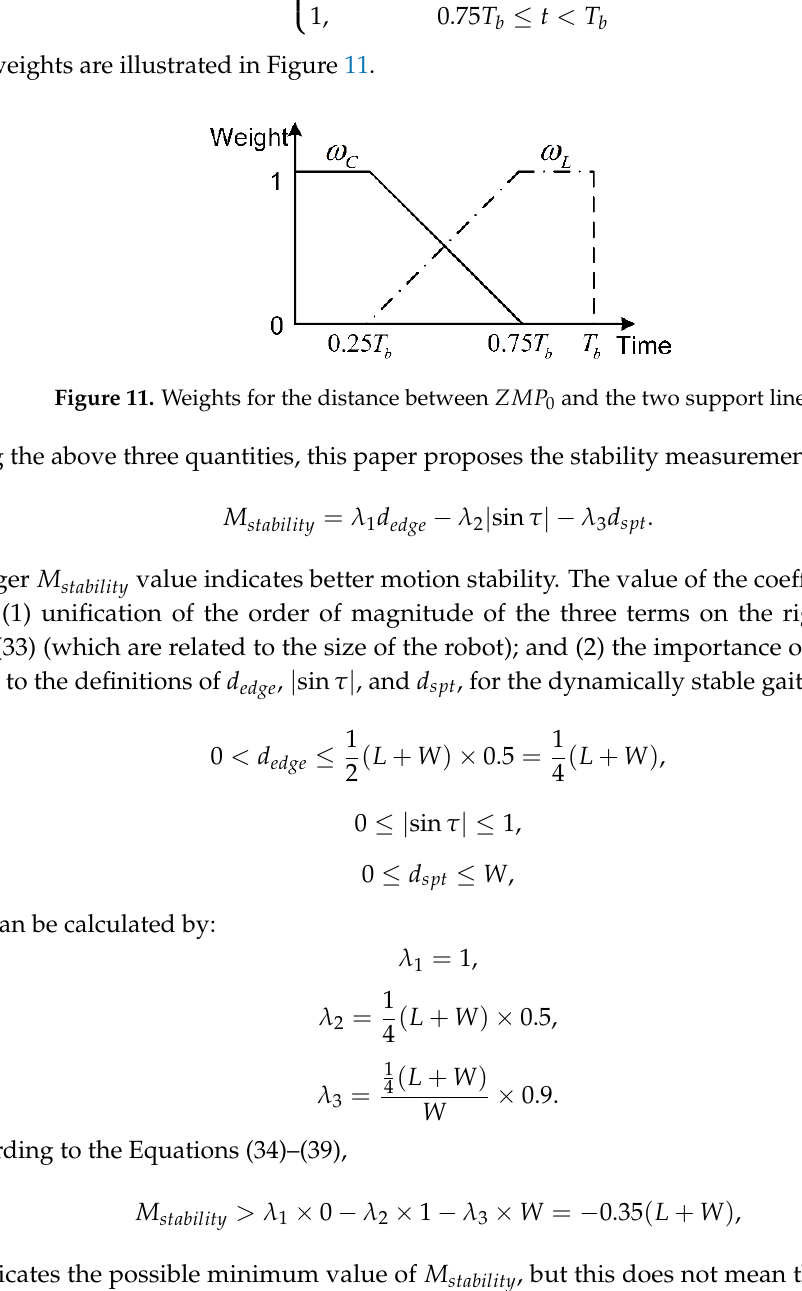
( b ) Figure 12. ( a ) Simplified; and ( b ) mechanical models of the quadruped robot.